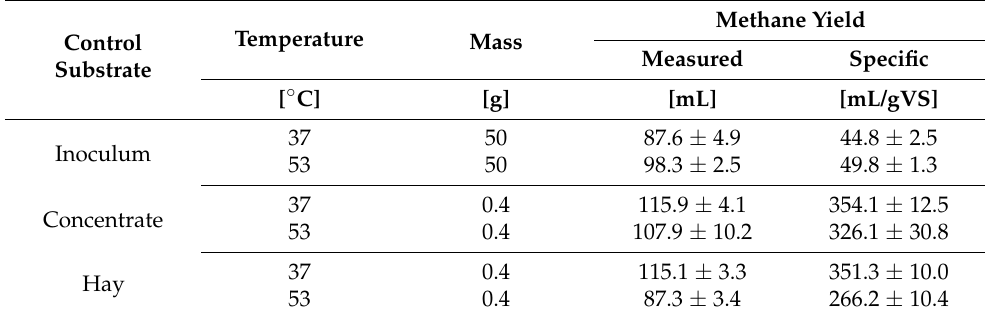
Table 4. Mean methane yields obtained from the given per batch-test amount of the control substrates (inoculum, concentrate, hay) under mesophilic and thermophilic